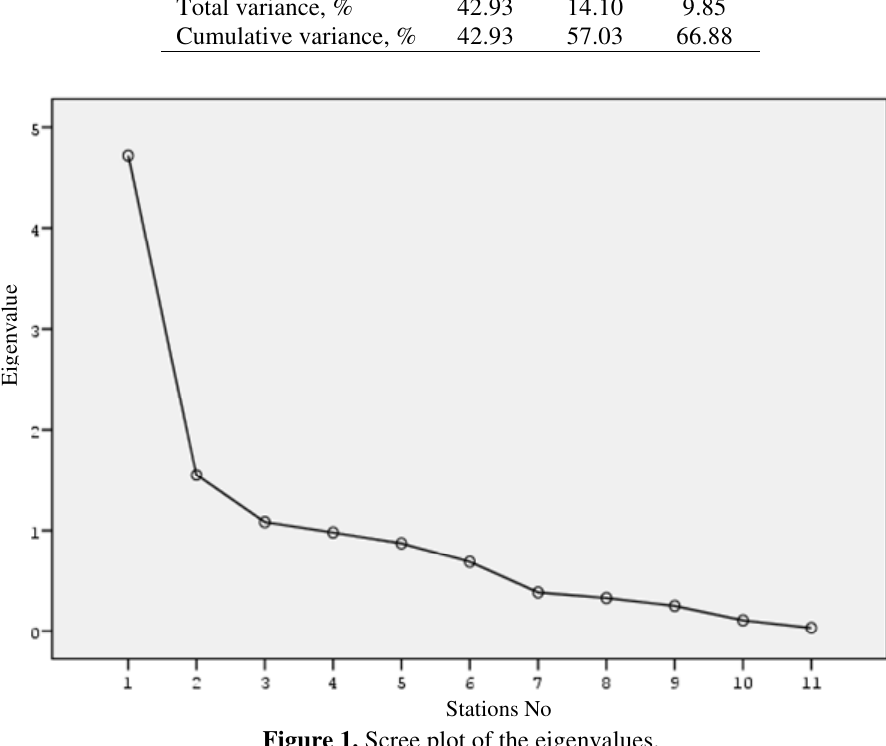
Figure 1. Scree plot of the